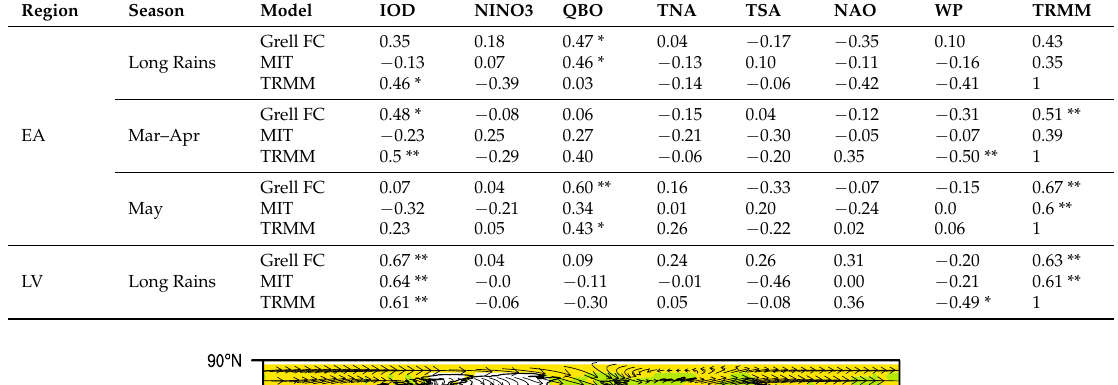
Table 5. Summary of the correlation of TRMM and model output EOF1 with the different indices used in the study for the Long-Rains Season. The ** indicates correlations that are statistically significant at 95% and * at 90%, significance of correlation was done using a Student’s t -test. Region